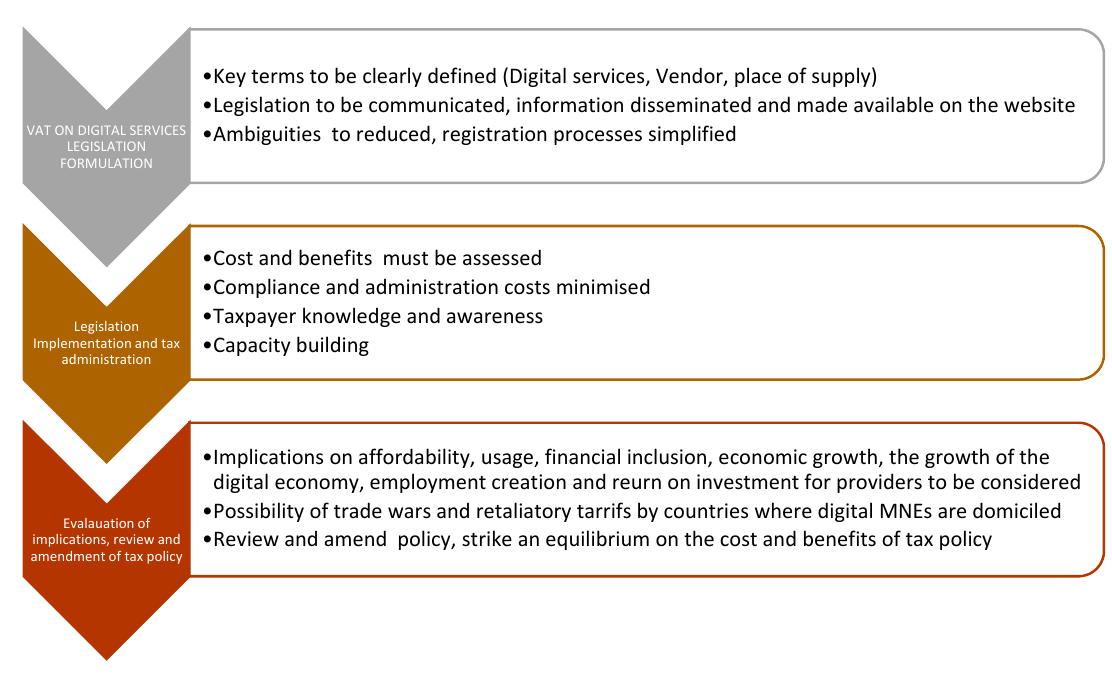
Figure 1. Summary of Recommendations to improving VAT legislation with respect to the digital economy. Source: Author’s Compilation.